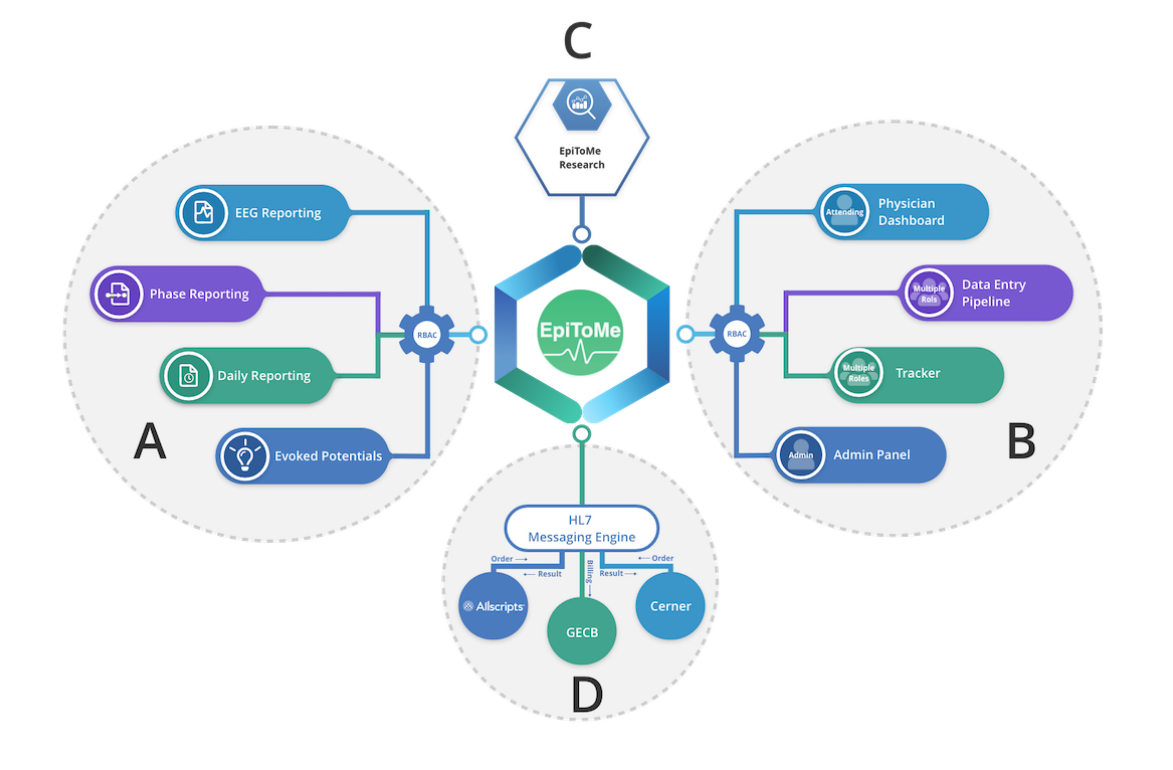
Figure 2. EpiToMe's functional architecture with 4 major functional areas: (A) data capture interfaces for clinical reports, (B) data and analytical dashboards, (C) clinical research query interface, (D) HL7 messaging engine for communication with background electronic health record systems (Allscripts, Cerner, and EPIC). Role-based access control can be configured to manage who gets which levels of access to what information, as defined by their clinical roles. EEG: